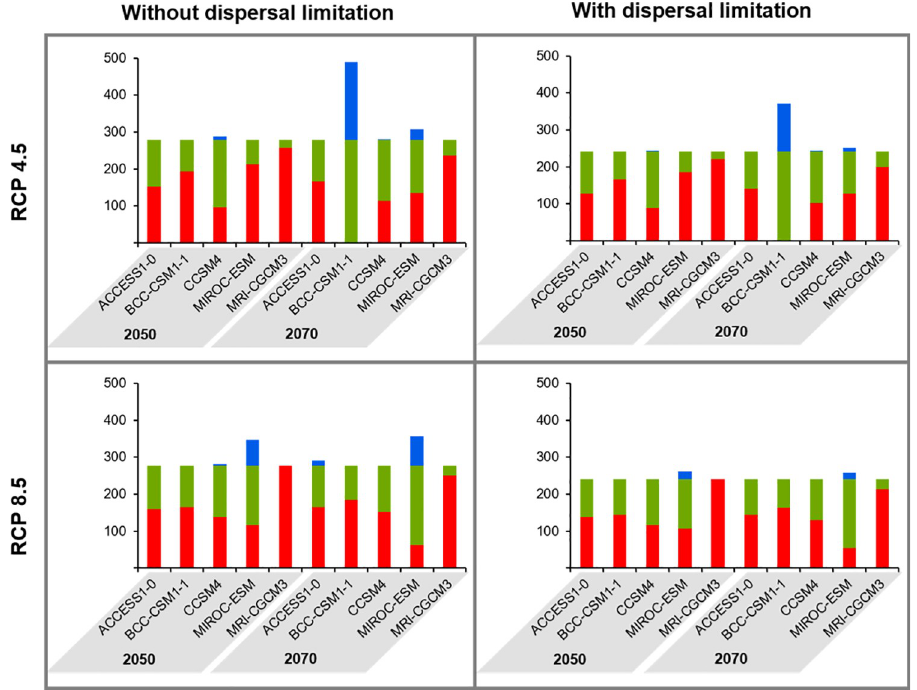
Fig 8. Number of cells in each category of predicted change. The colours correspond to the categories of habitat change as follows: Green–Habitat Maintained; Red–Habitat Lost; Blue–Habitat Gained. The bar plots on the left correspond to the unrestricted scenario, where C . ladanifer subsp. sulcatus can disperse everywhere, contrarily to the bar plots on the right, which consider the dispersal limitation polygon, represented in Fig 7, as the exclusive area where it may be present, both currently and in the future. The top bar plots illustrate the projections for the Representative Concentration Pathway (RCP) 4.5 while the bottom bar plots represent the RCP 8.5 projections.